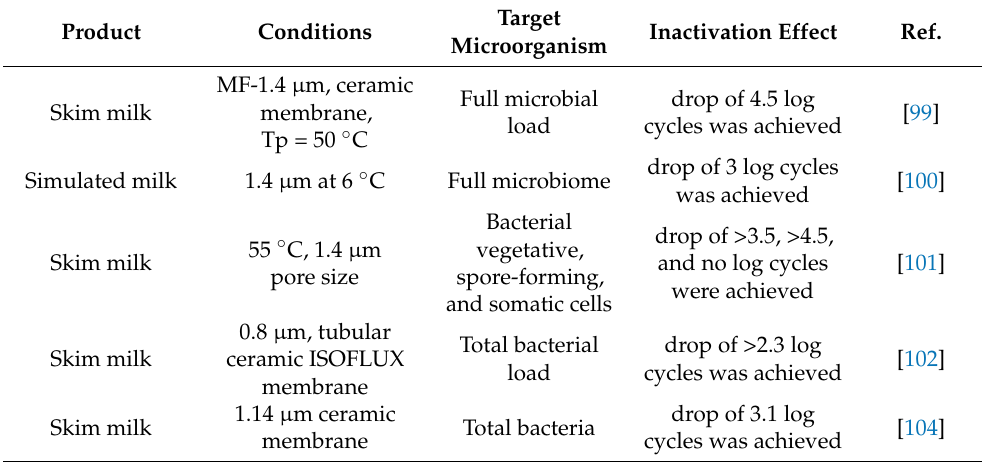
Table 6. Inactivation of microorganisms by membrane filtration treatment in milk and milk